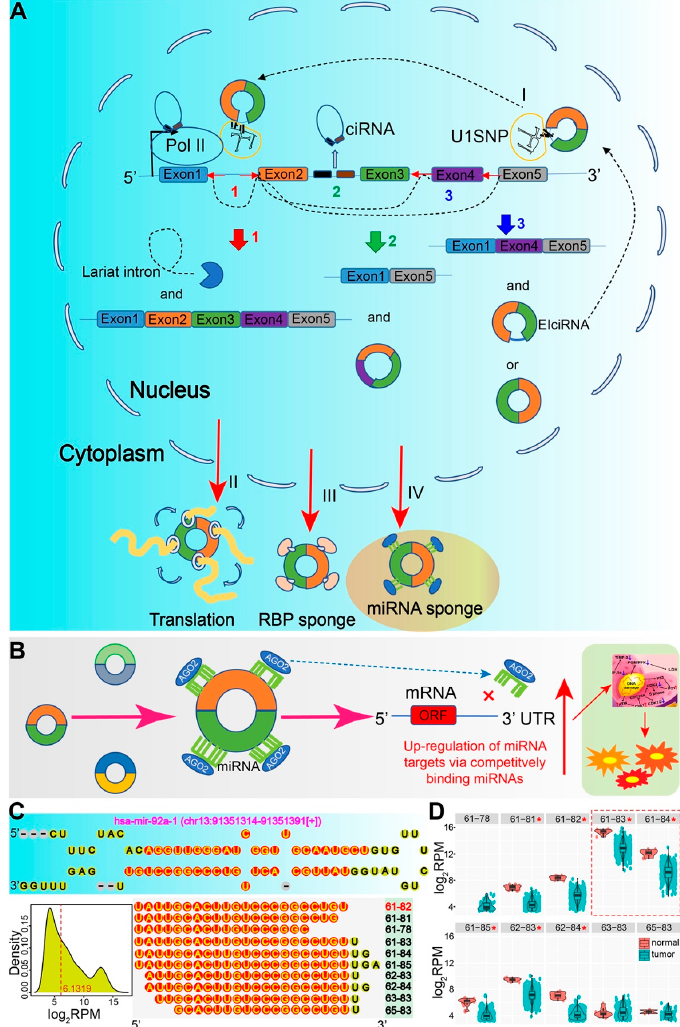
Figure 1. CircRNA biogenesis and multiple isomiRs in miRNA. ( A ): There are three types of circular RNAs: intronic circRNAs (ciRNA), exonic circRNAs with introns (EIciRNA), and exonic circRNA (ecircRNA). 1–3 indicates that alternative splicing of the same gene can produce three circRNAs; I-IV show that circRNA can regulate the expression of parent gene, acting as a miRNA sponge, interacting with RNA binding protein (RBP), and translating polypeptide, respectively; ( B ) CircRNA can bind to miRNA through miRNA response element (MRE), which further up-regulates the target gene regulated by miRNA. The dysregulation of target mRNAs may disturb relevant biological processes that can further contribute to cancer pathophysiology and developmental process; ( C ) Take hsa-mir-92a-1 as an example to demonstrate multiple isomiRs in miRNA locus due to alternative and imprecise cleavage of Drosha and Dicer, 3 (cid:48) addition events, etc. The detailed expression data are derived from the colon adenocarcinoma cohort in TCGA (TCGA-COAD). The pre-miRNA stem-loop structure is presented, and the total expression distribution of multiple isomiRs in the miR-92a-3p locus is presented for all relevant isomiRs if reads per million mapped reads (RPM) >= 10. Ten dominantly expressed isomiR types are further screened if the isomiR type is detected in more than 40 individuals and has higher expression levels (the detailed locations on chromosomes are used to name the isomiR type). The highlighted red locations, 61–82 (chr13:91351361–91351382[+]), are the canonical miRNA sequence in the miRbase database [16,17]; ( D ) The detailed expression distributions for the ten isomiR types between normal and tumor samples. Except for 3 isomiR types, others show a significant expression difference in tumor samples than that in normal samples (significant down-regulated, padj < 0.05). Of these, the isomiRs of 61–83 and 61–84 are unexpectedly dominantly expressed, despite the fact that they are not canonical miRNA sequences. * indicates padj < 0.05 based on DESeq2 algorithm